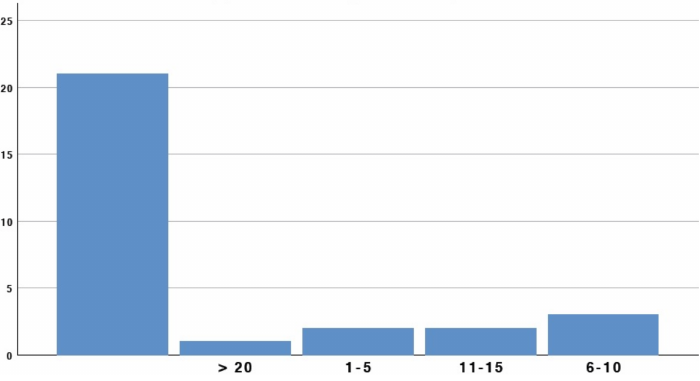
Figure 4. LAMS placement experience.